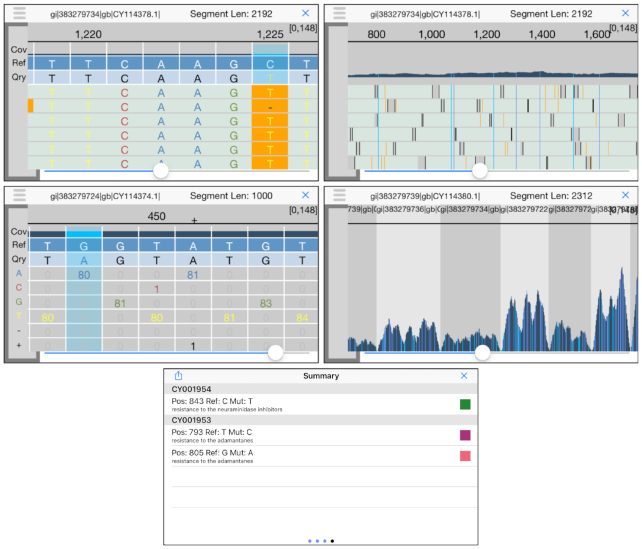
iGenomics iPhone screenshots (top left) alignments display, (top right) alignment display zoomed out, (middle left) coverage profile, (middle right) coverage profile zoomed out, and (bottom) known mutations display. In the known mutations display, green indicates the mutation is not present, purple indicates the listed mutation is present and the mutation is homozygous, and pink indicates the listed mutation is present and the mutation is heterozygous. In both the alignments display and coverage profile, there is an indicator in the top right of the form [X, Y] that represents the minimum coverage X across all positions and maximum coverage Y across all positions.